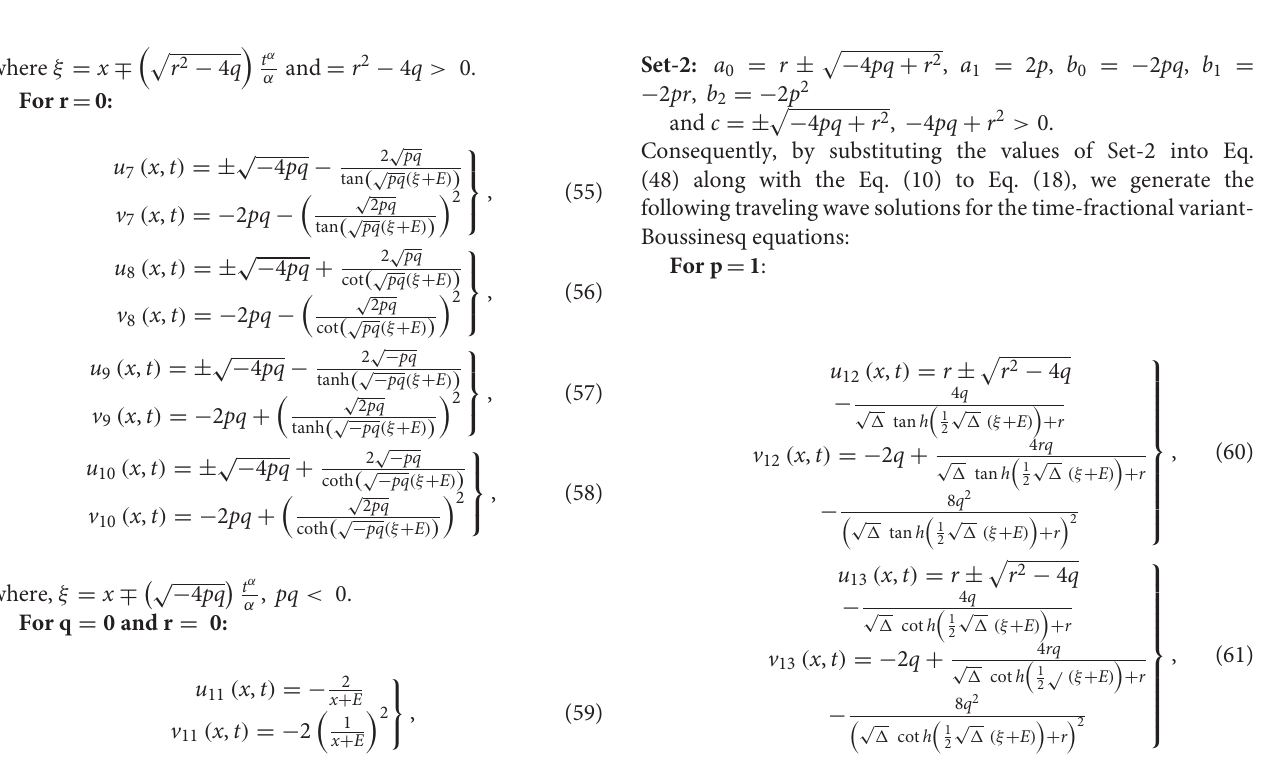
FIGURE 1 | (A–D) The Solution u_1 (x,t) given by Eq.